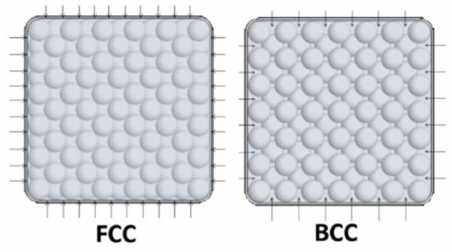
Figure 7. Voids near the